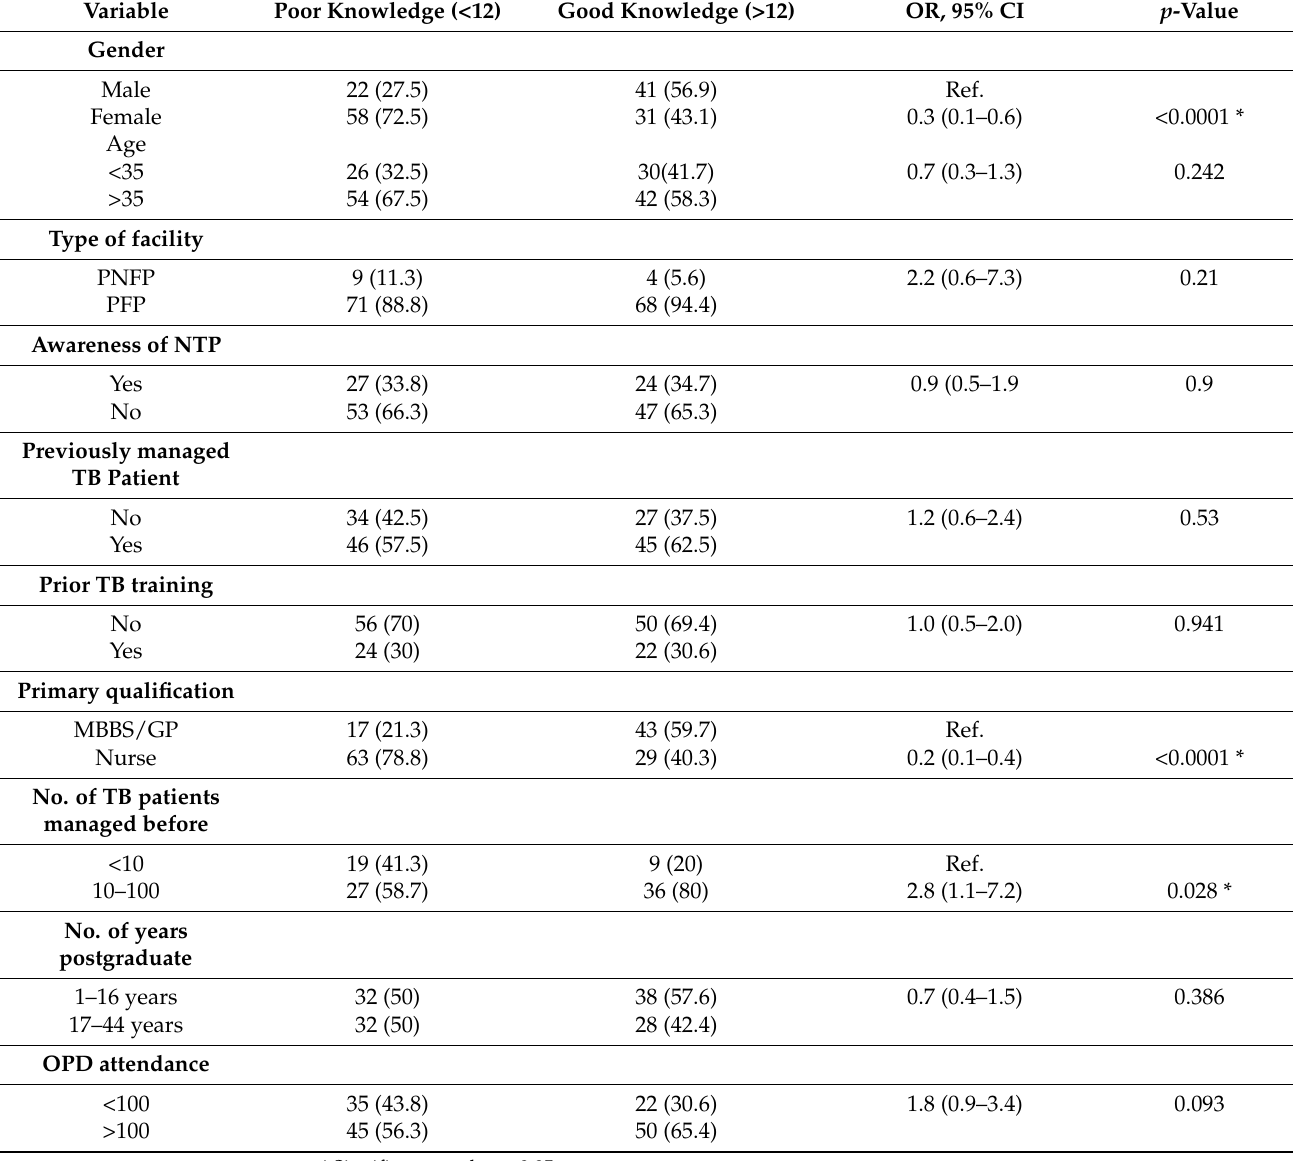
Table 4. Factors associated with total knowledge of tuberculosis among private non-NTP engaged providers in Lagos,